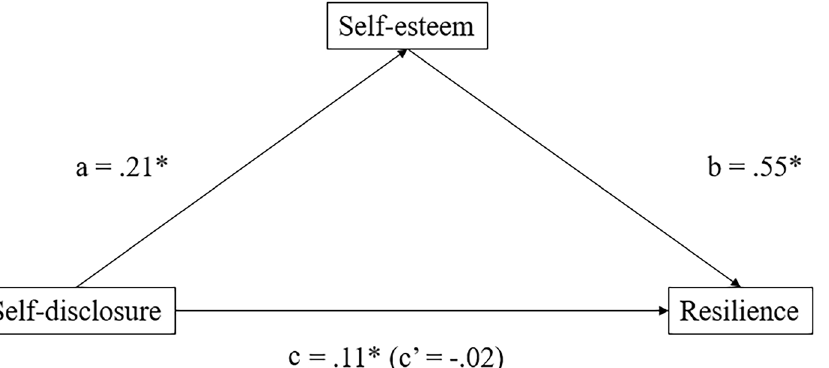
Self-Esteem, Self-Disclosure, and Resilience Mediation Model